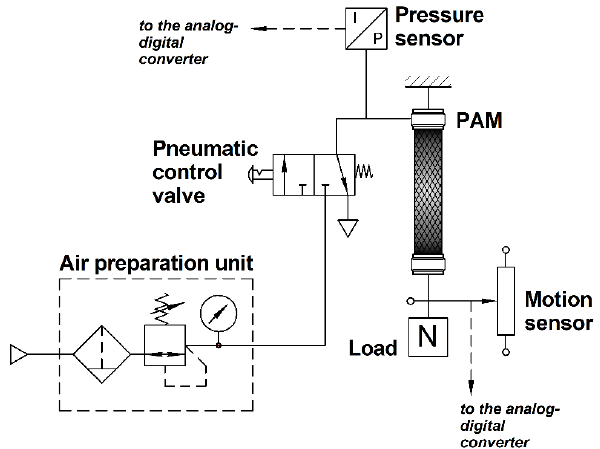
Figure 12. The crucial pneumatic scheme of the experimental setup.